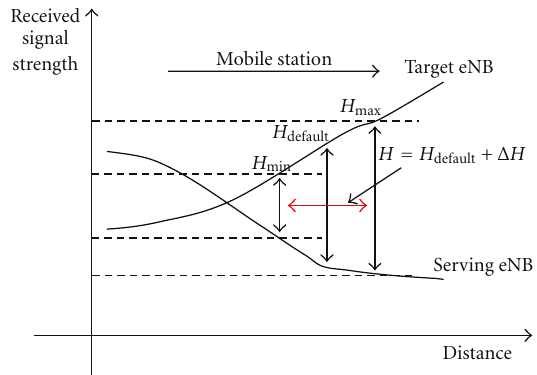
Figure 3: An example of the hysteresis values in the proposed cost- based adaptive hysteresis